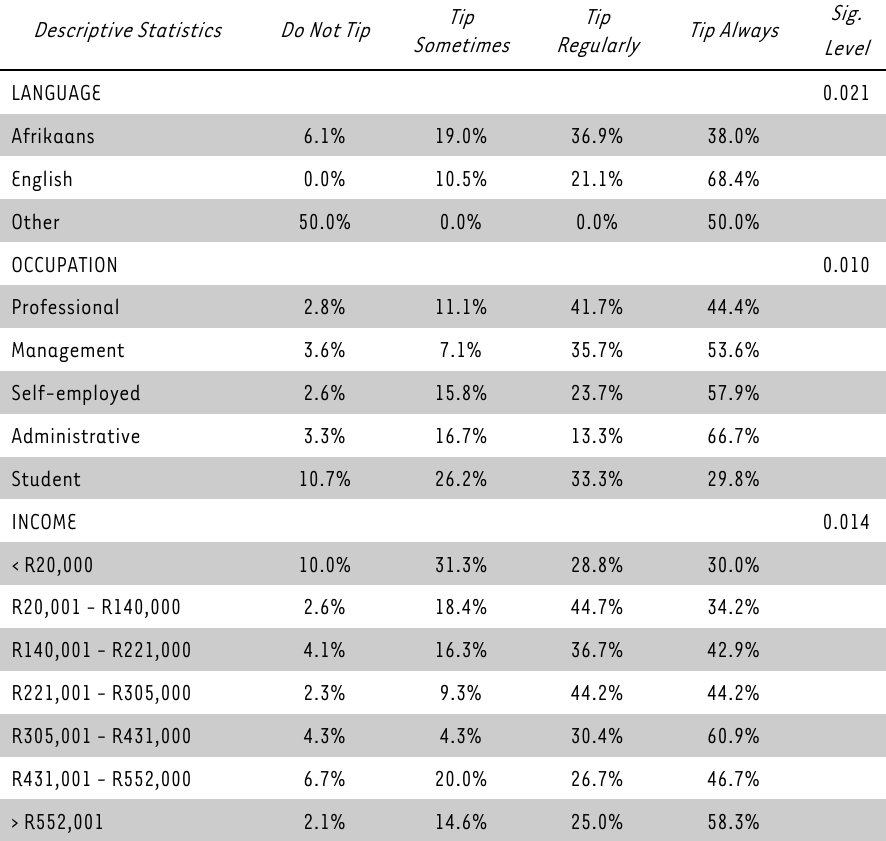
TABLE 1: Descriptive